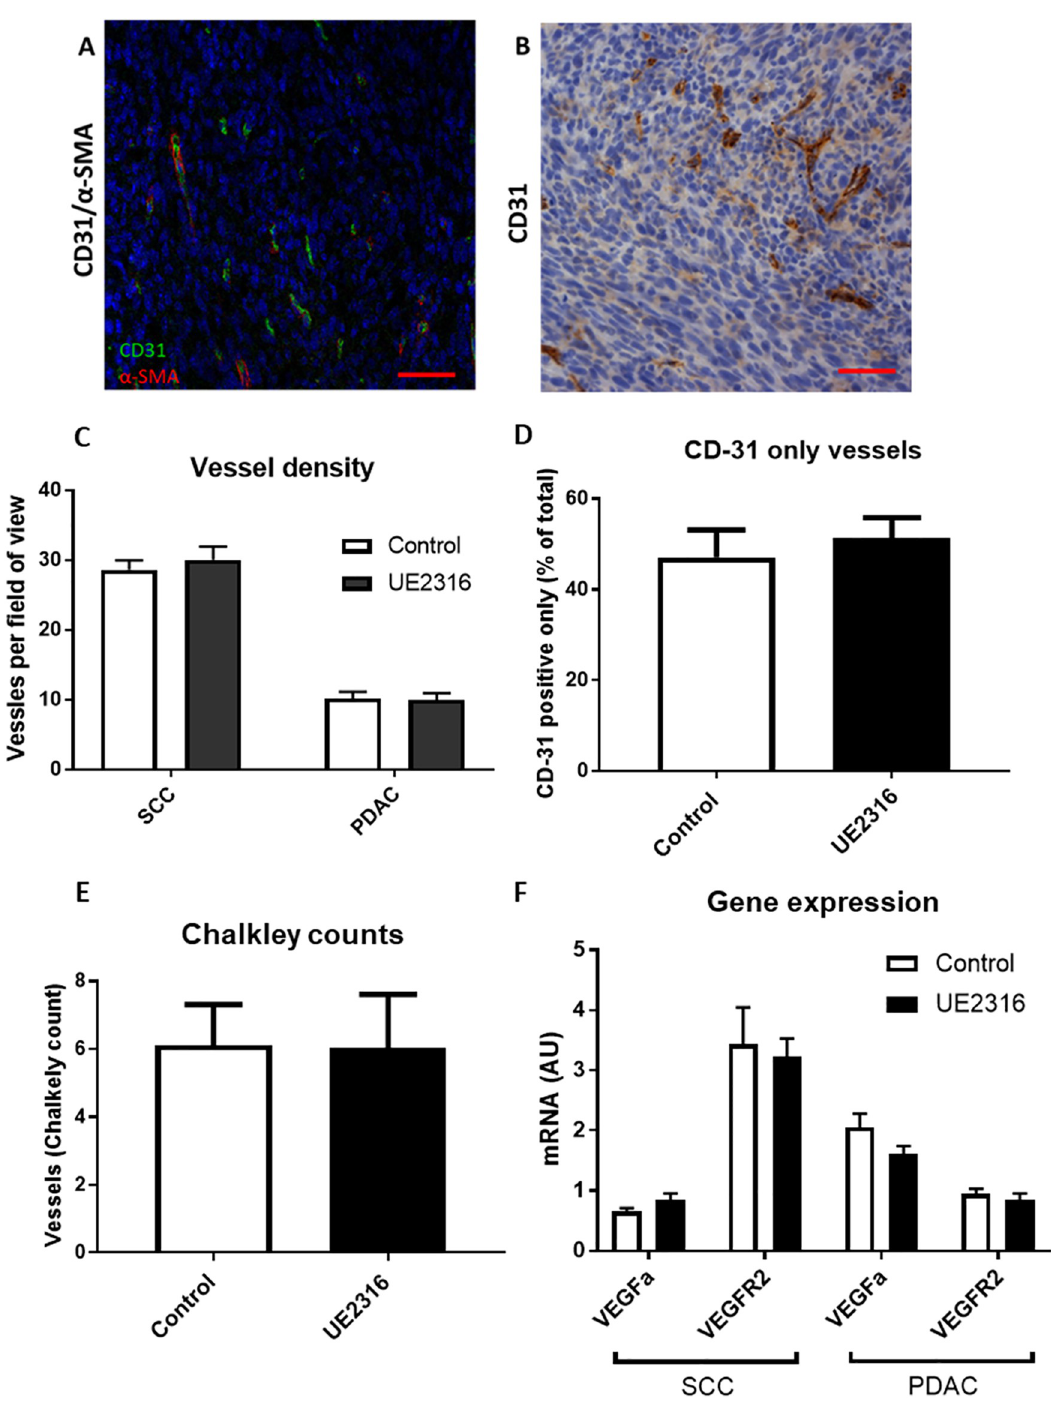
Fig 3. UE2316 does not affect angiogenesis in tumours. A) Tumour tissue from SCC tumours; endothelial cells are stained green (CD31 visualised with Alexa-Fluor 488), smooth muscle cells are stained red ( α -SMA visualised with Cy3) and nuclei are stained blue (DAPI). Tumours had densely packed nuclei. 200x magnification. Scale bar 50 μ m. B) CD31 was also visualised with diaminobenzidine (DAB) for counts. 200x magnification. Scale bar 50 μ m. C) UE2316 did not affect vessel density in either SCC or PDAC tumours. D) UE2316 did not affect the proportion of vessels lacking smooth muscle coverage in SCC tumours (i.e. CD31 positive but α -SMA negative). (E) UE2316 did not affect Chalkely counts in SCC tumours. 1 section/tumour, N = 5–6 animals/ group. F) mRNA levels for Vegfa and Vegfr2 in SCC tumours were unaffected by UE2316. Data were compared by independent samples t-test for panels C/D, Mann-Whitney U test for Panel E.